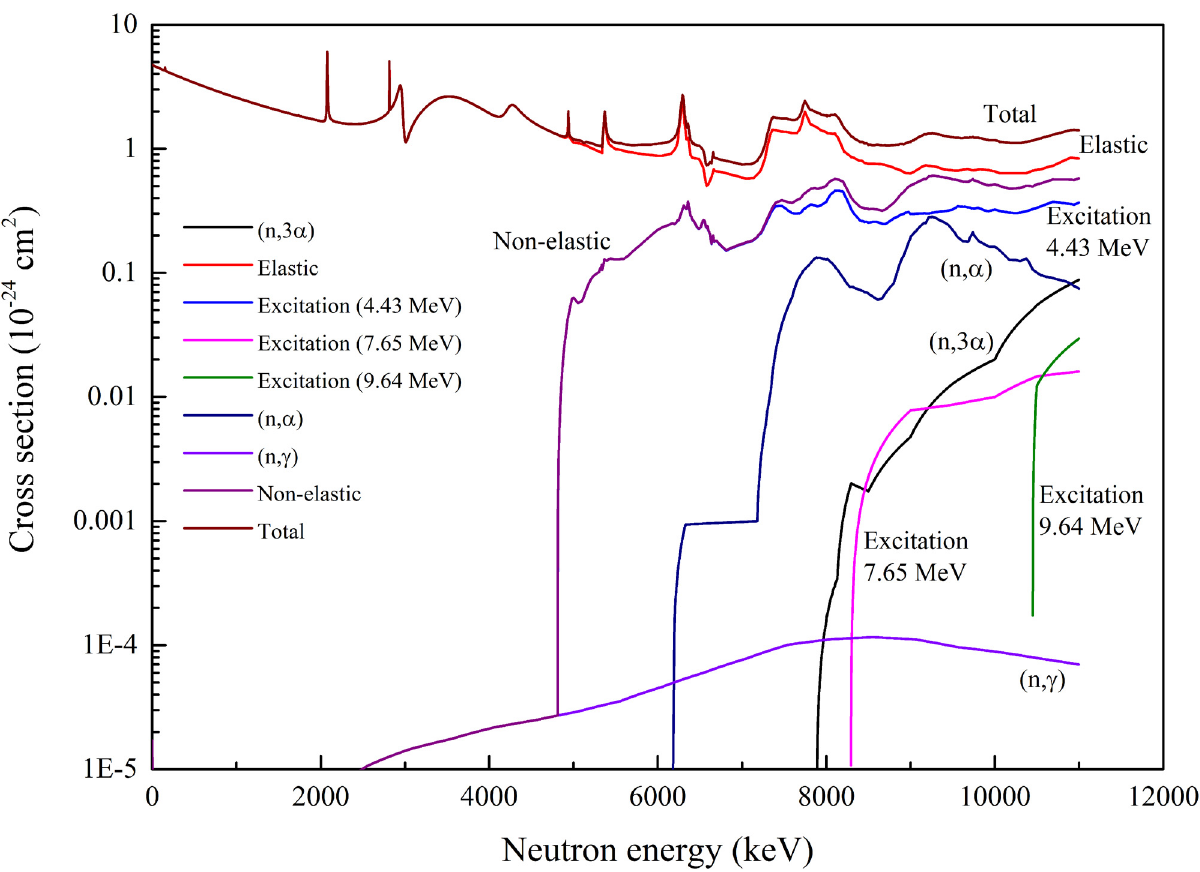
Fig 1. Cross sections for different nuclear reactions between neutrons and 12 C